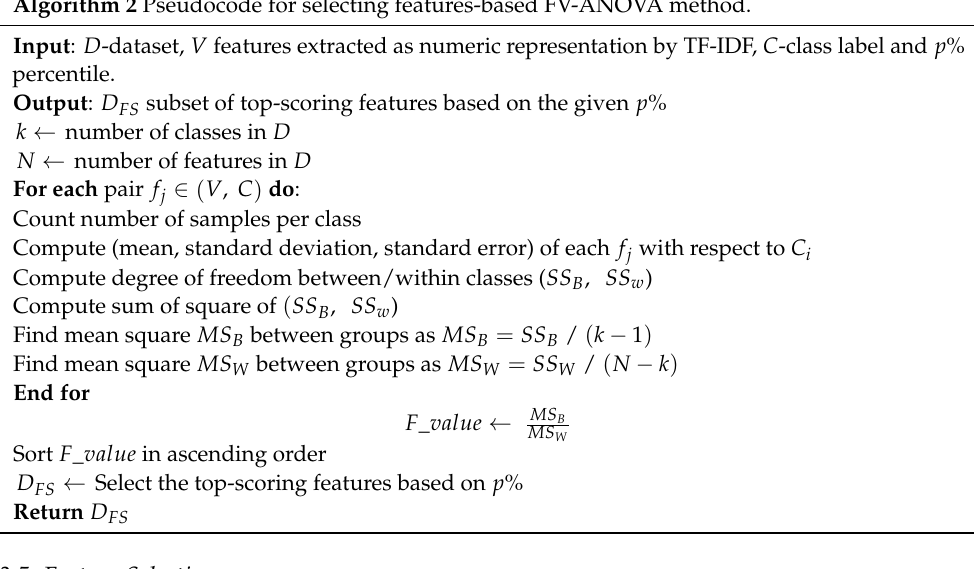
Algorithm 2 Pseudocode for selecting features-based FV-ANOVA method.